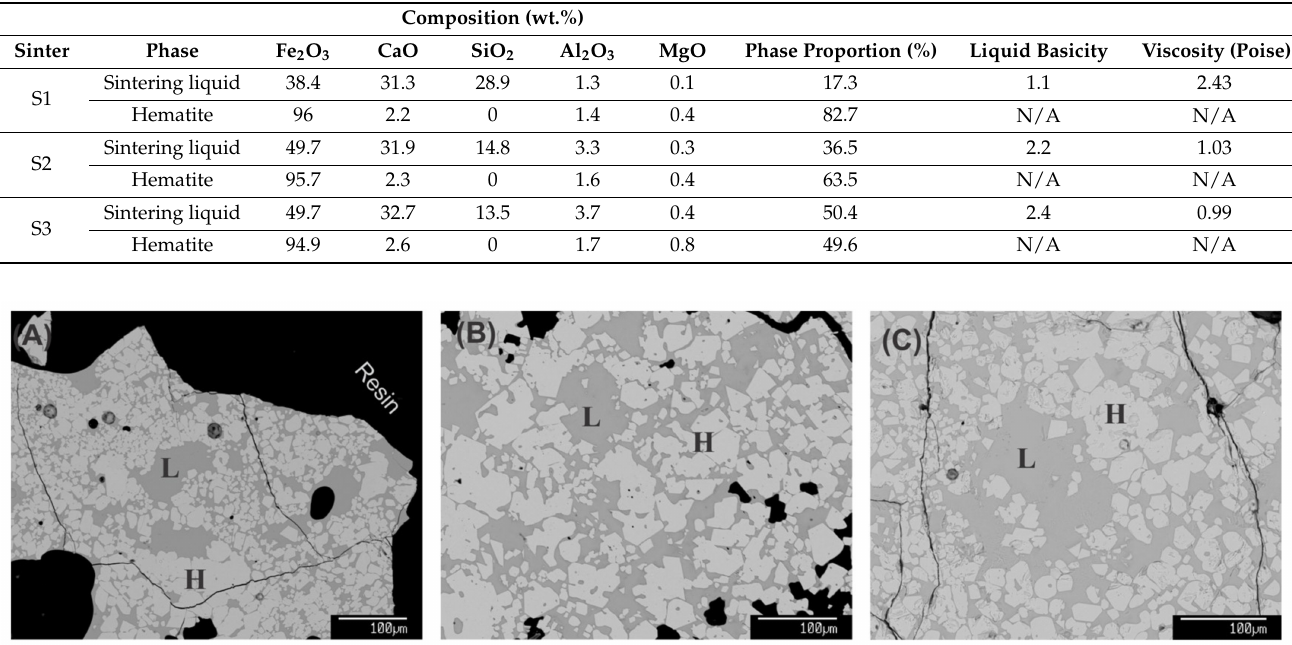
Table 2. Phases and phase compositions present upon reheating the three sinters at 1300 ◦ C for 10 min and Po 2 of 0.01 atm, followed by quenching and EPMA.